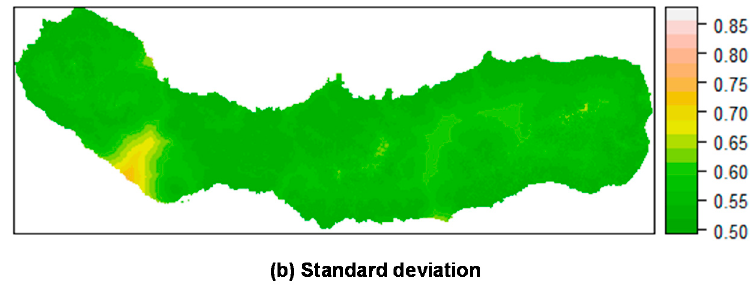
Figure 8. Prediction of M. faya occurrence in São Miguel Island by posterior mean ( a ) and standard deviation ( b ) of the linear predictor. Top: Mixed effects model including a random field; Bottom: Fixed effects model (without a random field). All models calculated using INLA.